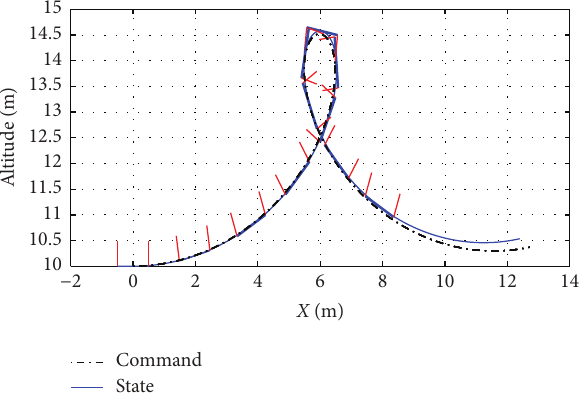
Figure 17: Visualisation of constant thrust